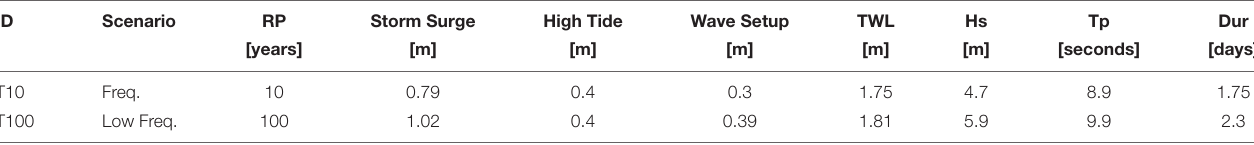
ID Scenario RP Storm Surge High Tide Wave Setup